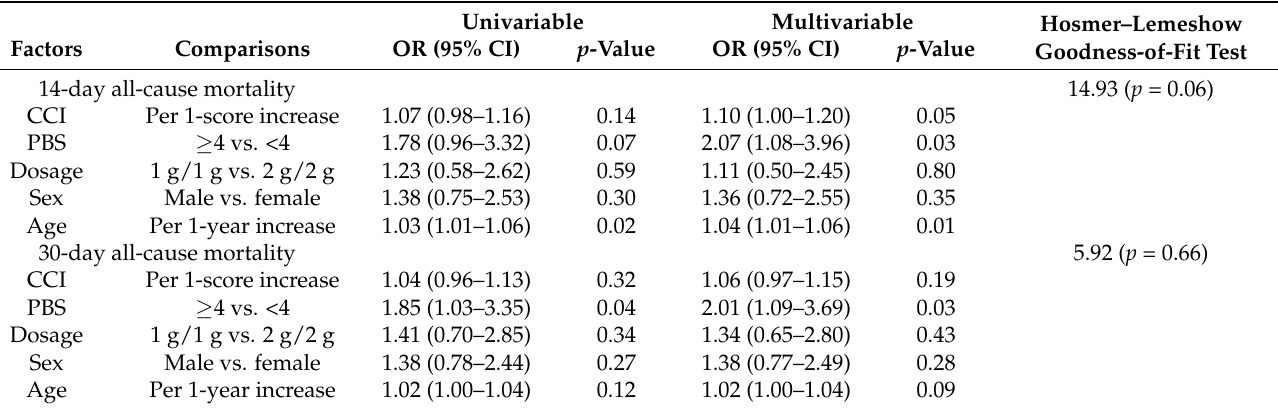
Table 4. Univariable and multivariable logistic regression analysis of factors in CGRD cohort associ- ated with 14-day or 30-day all-cause mortality.